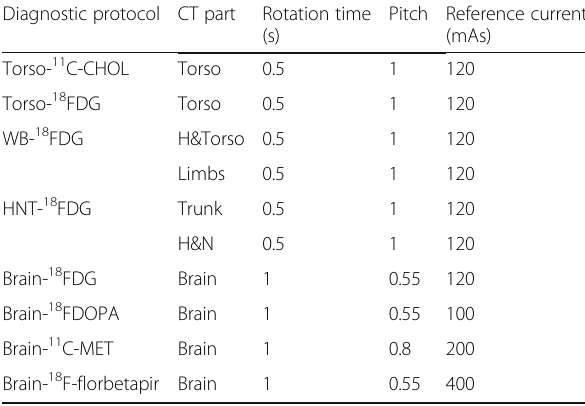
Table 2 Main technical parameters used for the CT protocols Diagnostic protocol CT